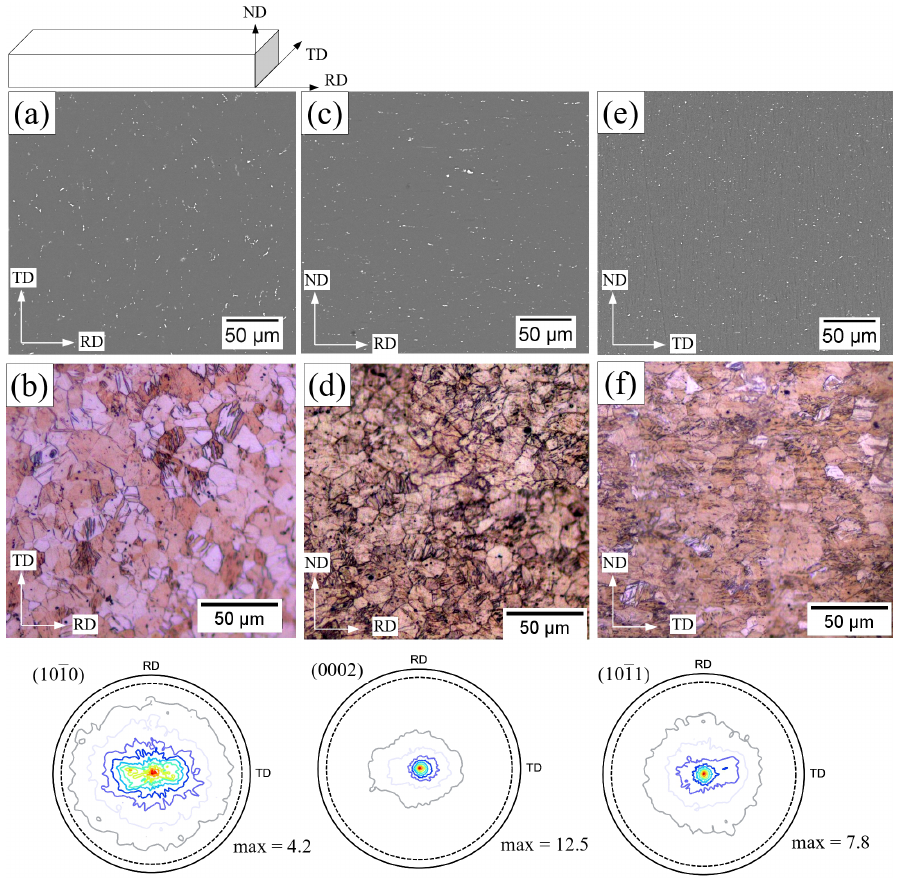
Figure 5. SEM/BSE ( a , c , e ) and LOM micrographs ( b , d , f ) of aged-10 h specimen; and pole figures of {1010}, {0002} and {1011}